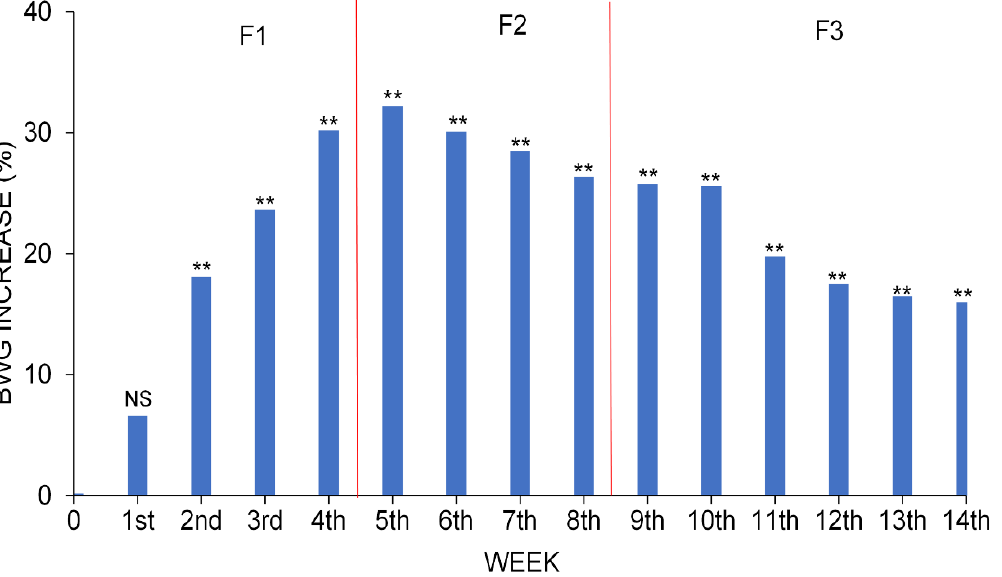
Figure 3. BWG percentage increase in the C group over the TM group throughout the whole study period. NS or **: non-significant or significant at p < 0.01, respectively.